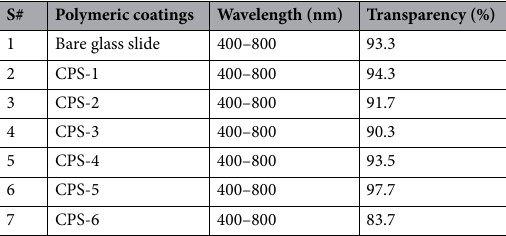
Table 6. Transparency of polymeric coatings.